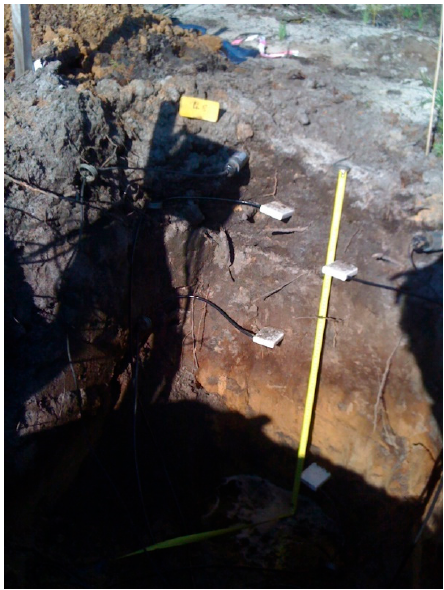
Figure 3. Installation of the soil moisture sensors at Hermitage site.